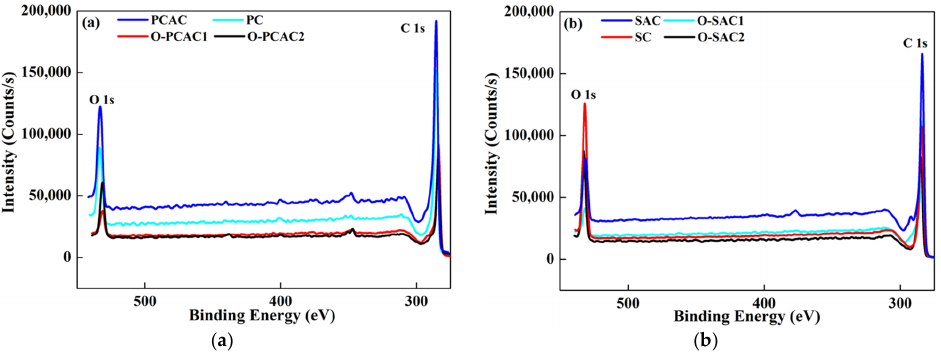
Figure 3. X-ray photoelectron spectroscopy (XPS) survey scans of pulverized coal (PC)-based ( a ) and starch-based carbon (SC)-based ( b ) samples. Table 2. Assignments and peak parameters of different O 1s components of adsorbents.